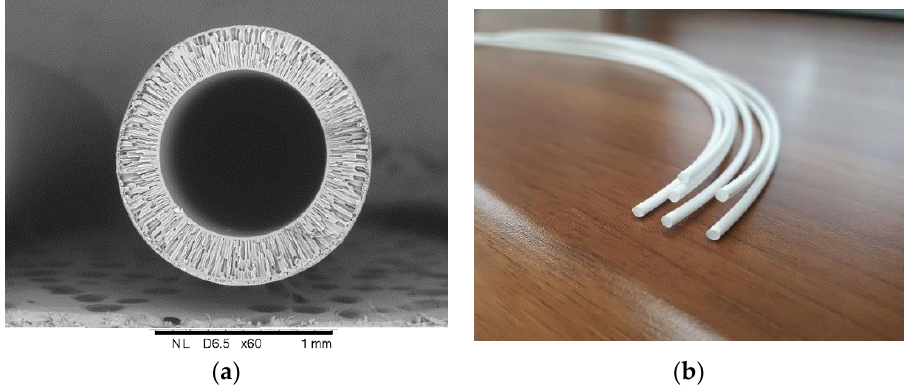
Figure 1. Asymmetric mesoporous hollow fiber membrane from polysulfone for gas-liquid membrane contactor (developed in A.V. Topchiev institute of petrochemical synthesis): ( a ) Cross-sectional image; and, ( b ) General view.